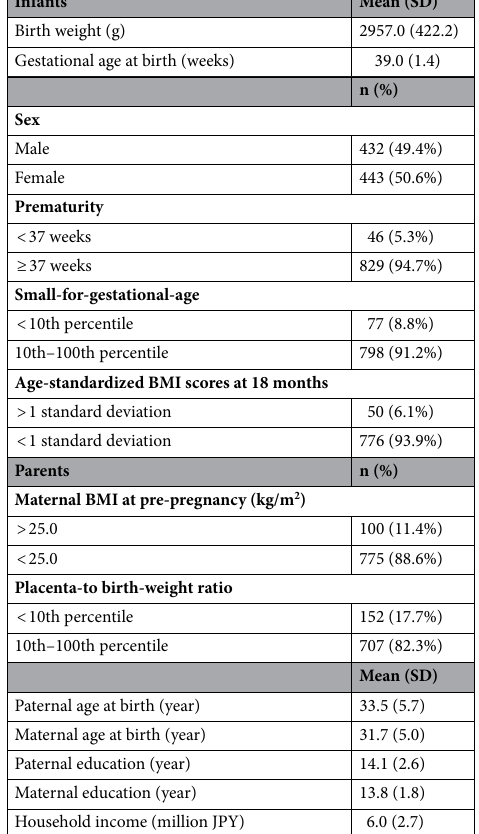
Table 1. Characteristics of participating infants and their parents. SD standard deviation, BMI body mass index, JPY Japanese